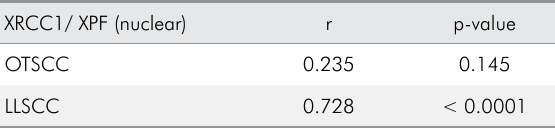
Table 4. Correlation between XRCC1 and XPF